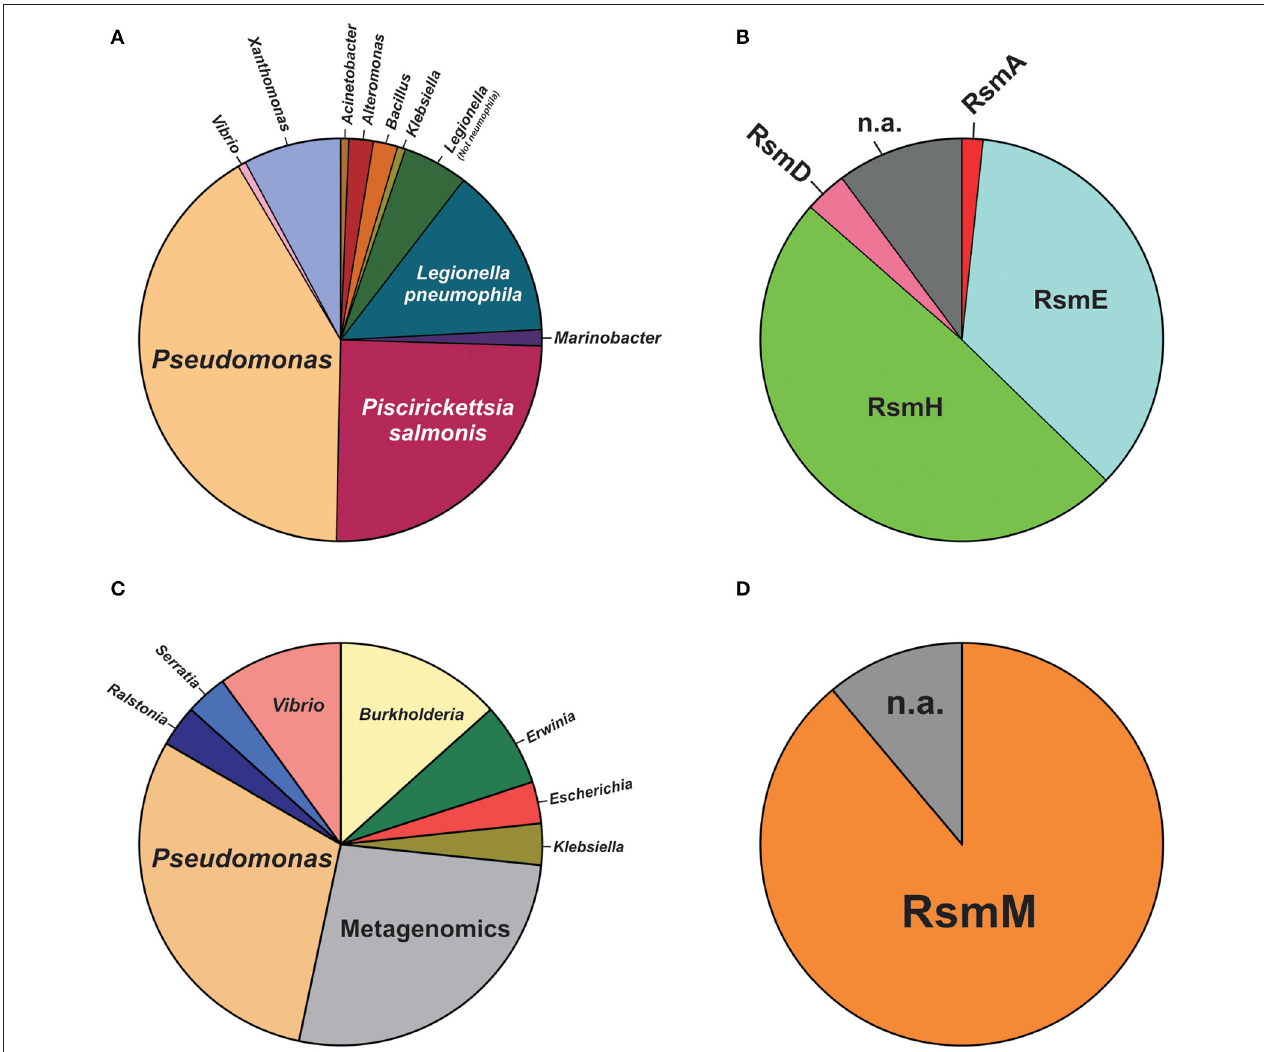
FIGURE 8 | Species distribution of CsrA homologs in natural plasmids and phages of the genus Pseudomonas . (A) Pie chart illustrating the proportional distribution (%) of plasmids deposited in the PLSDB database (https://ccb-microbe.cs.uni-saarland.de/plsdb/) bearing a csrA allele and hosted by different eubacterial host taxa. The total number of plasmids is 161 (for details, see Supplementary Table 6 ). (B) Distribution of Rsm paralogues within the 61 plasmids hosted by Pseudomonas species. n.a.: not assigned. (C) Distribution (%) of phages deposited in the NCBI viral genomes database